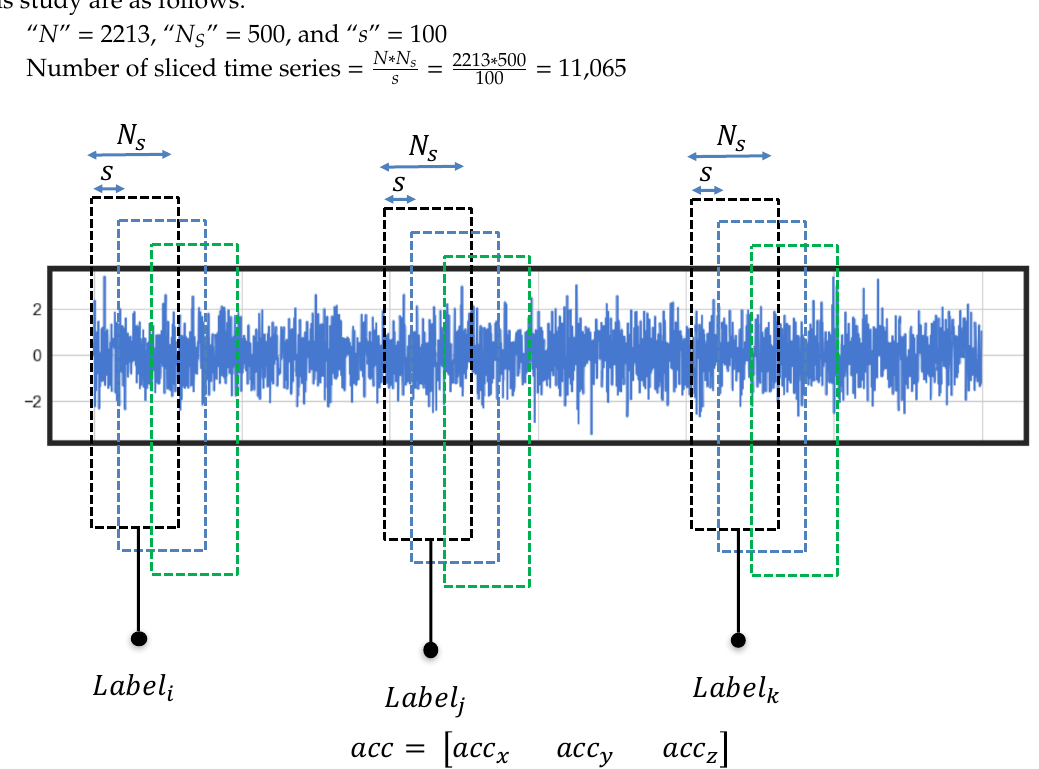
Figure 8. A typical time-window slicing based data